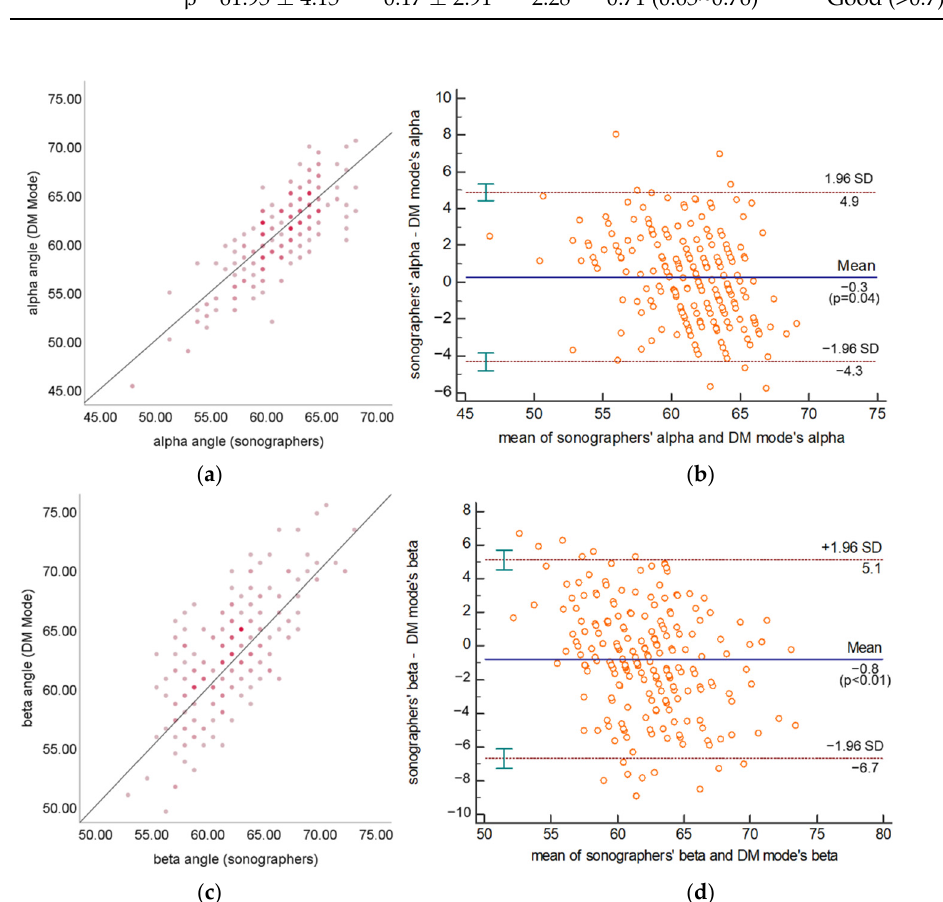
Table 4. Classification performance of DM w/o. SPSM, DM w. SPSM, and SM mode.